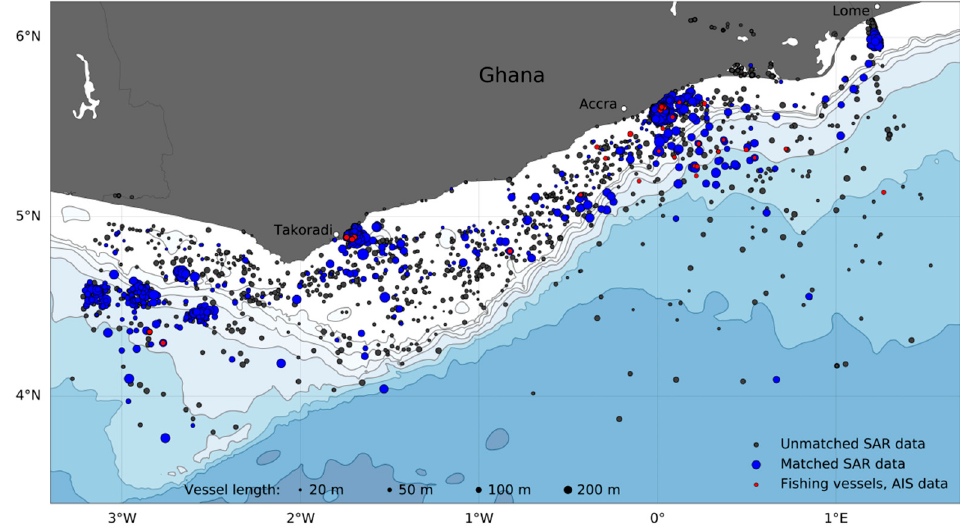
Figure 19. The distribution of vessels detected in SAR: unmatched SAR vessels of length < 110 m are shown in black; SAR data matched to AIS are shown in blue; vessels detected by SAR and identified as fishing by AIS are shown in red.